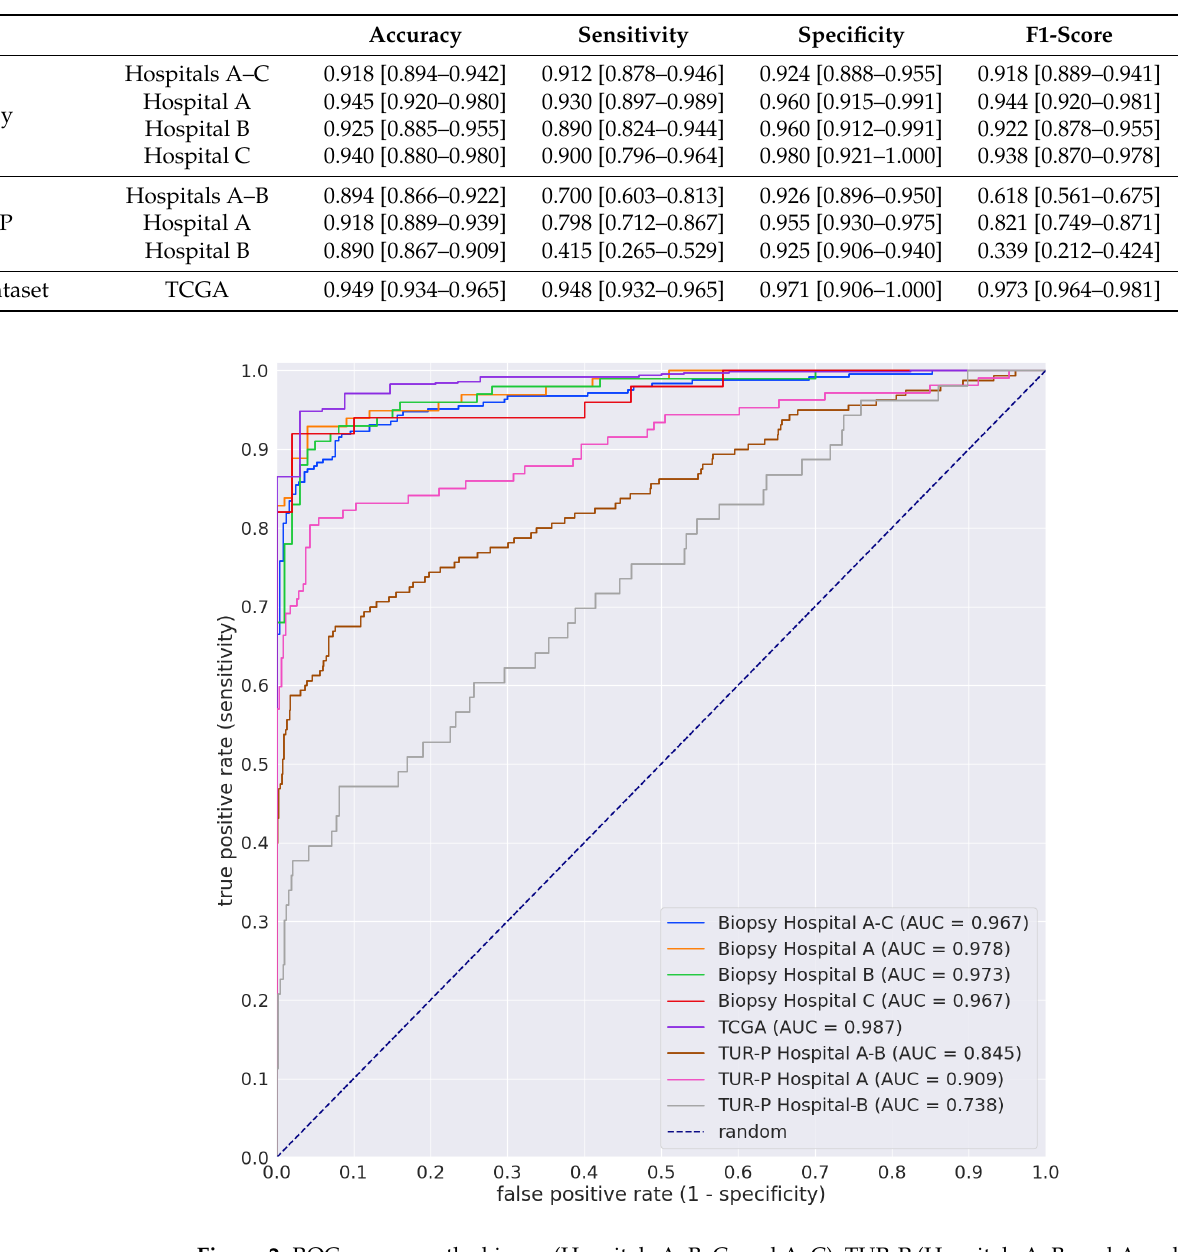
Figure 2. ROC curves on the biopsy (Hospitals A, B, C, and A–C), TUR-P (Hospitals A, B, and A and B), and TCGA test sets of the TL-colon poorly ADC-2 (20 × , 512) model. The model (TL-colon poorly ADC-2 (20 × , 512)) achieved the highest ROC-AUCs of 0.9873 (CI: 0.9881-0.995) and the lowest log loss of 0.0742 (CI: 0.0551–0.0959) for prostate adenocarcinoma on the TCGA test set (Table 4). On the needle biopsy test set, the model (TL-colon poorly ADC-2 (20 × , 512)) also achieved very high ROC-AUCs (0.967–0.978) with low values of the log loss (0.2094–0.3788) (Table 4). In contrast, ROC-AUCs on the TUR-P test set were lower than the biopsy test set, and the log loss on the TUR-P test set was higher than the biopsy test set (Table 4). In addition, accuracy, sensitivity, and specificity results on the model (TL-colon poorly ADC-2 (20 × , 512)) on the biopsy, TUR-P, and TCGA test sets are given in Table 5. The model (TL-colon poorly ADC-2 (20 × , 512)) achieved very